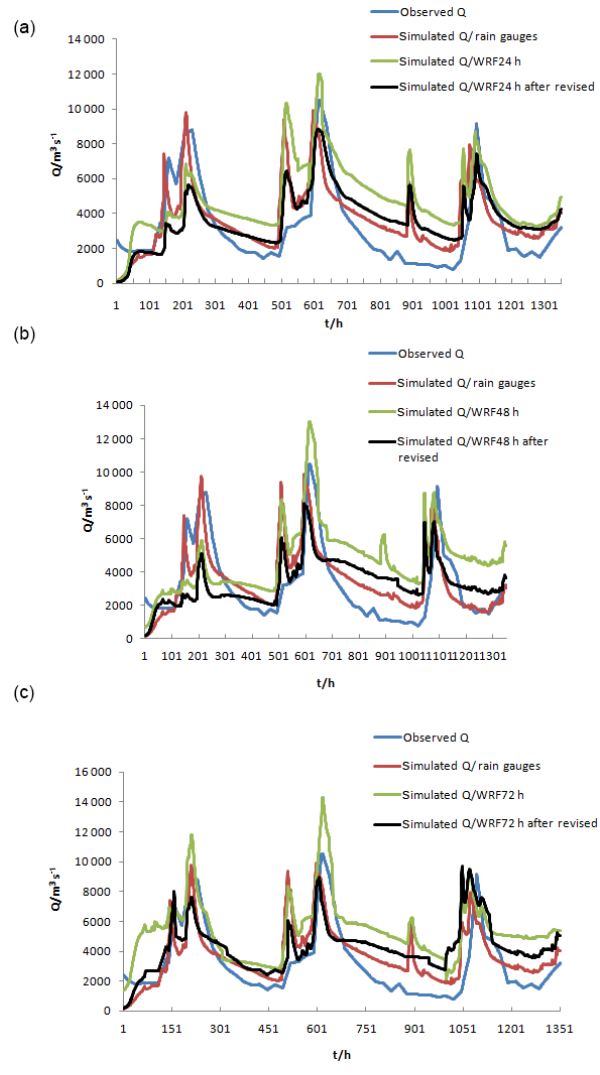
parameters (2012). (a) is the simulated result with 24h lead time, (b) is the simulated result with 48h lead time, and (c) is the simu- lated result with 48h lead